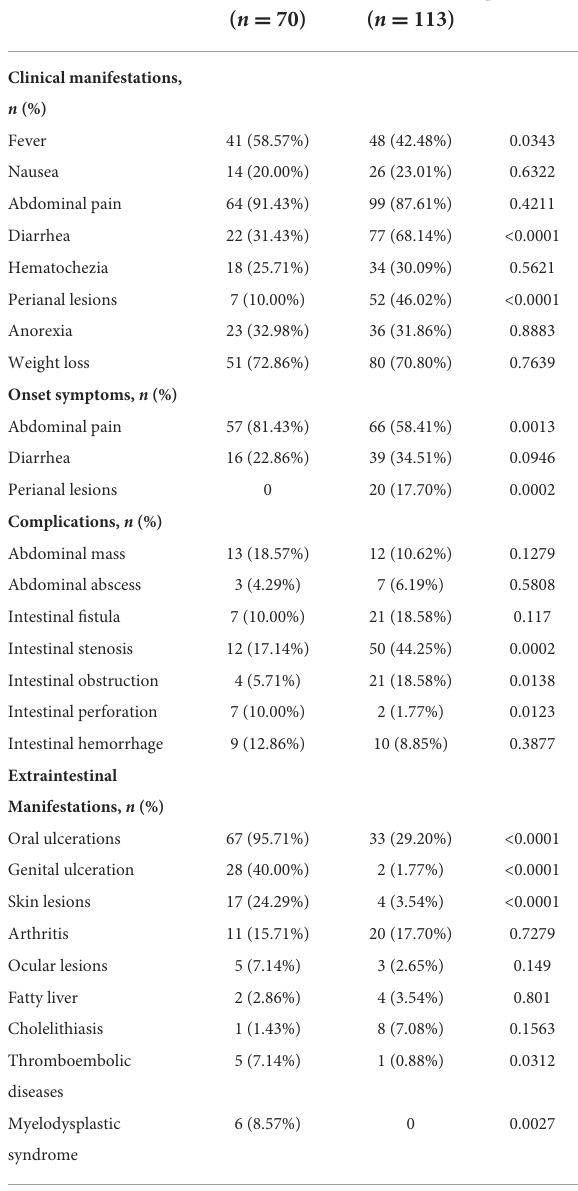
TABLE 3 Clinical characteristics of participants with CD or intestinal